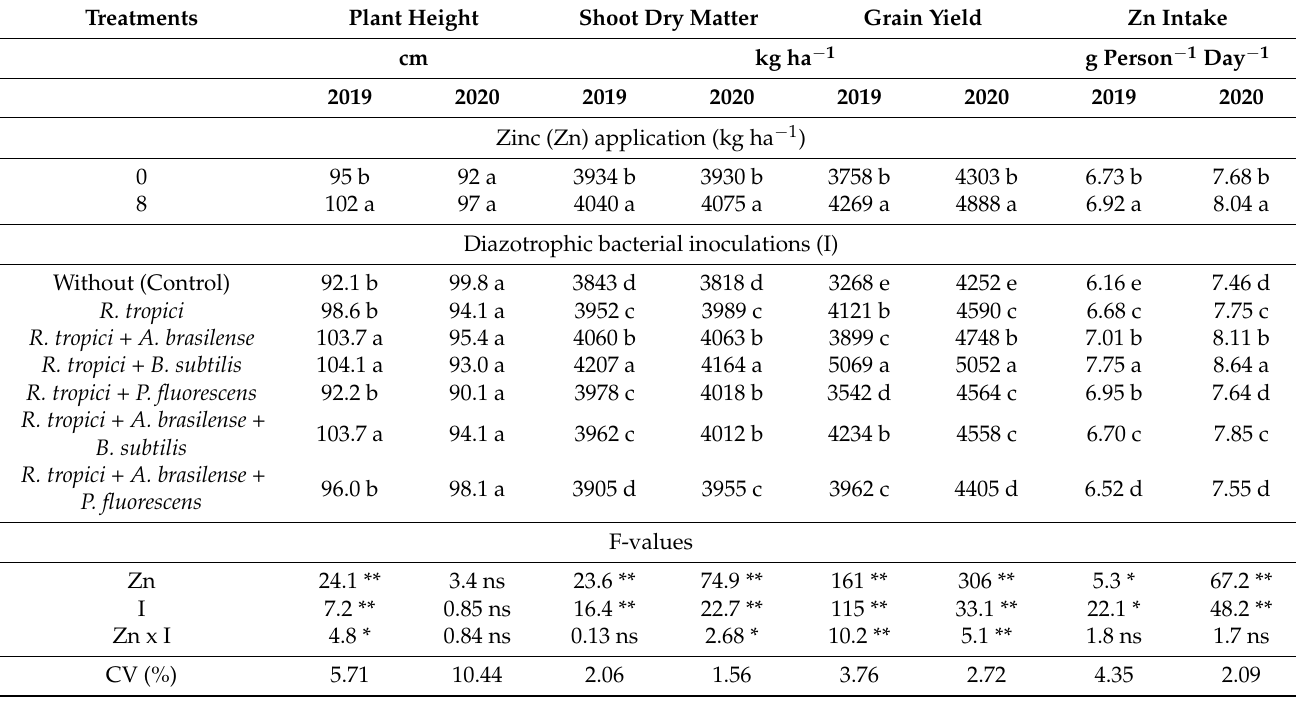
Table 4. Plant height, shoot dry matter, grain yield, and Zn intake in common bean under the influence of diazotrophic bacteria and soil applied zinc doses. Selv í ria—MS, Brazil, 2019 and 2020.